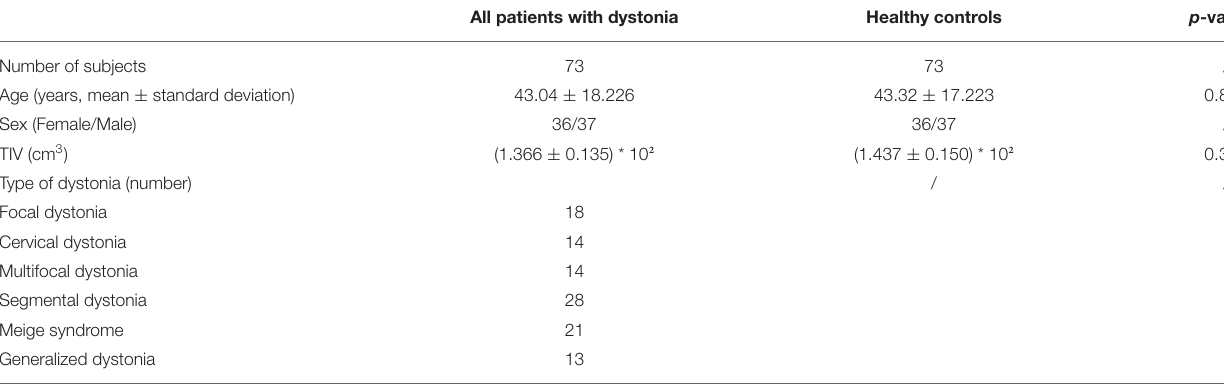
TABLE 1 | Demographic and clinical data.